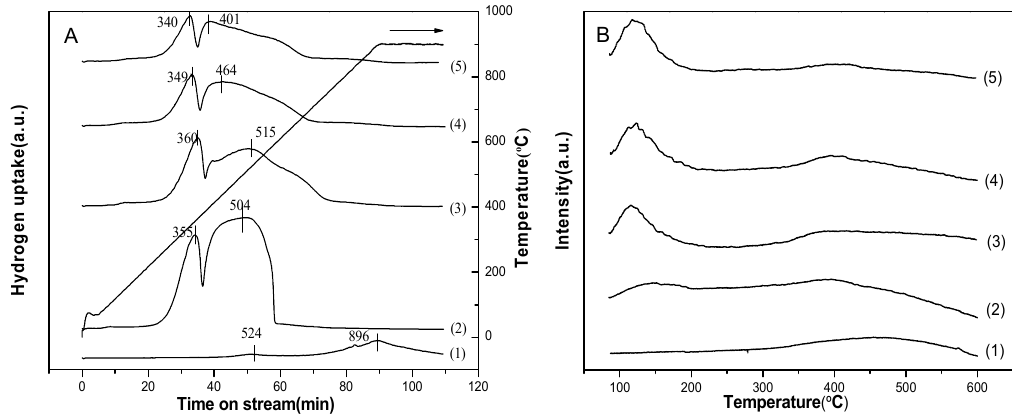
Figure 5. TPR profiles ( A ) and CO-TPD ( B ) profiles of the calcined catalysts: (1) CeO 2 in TPR or blank in TPD; (2) Co 3 O 4 ; (3) Co 3 O 4 -CeO 2 ; (4) Co 3 O 4 -CeO 2 -0.5; (5) Co 3 O 4 -CeO 2 -1.0.